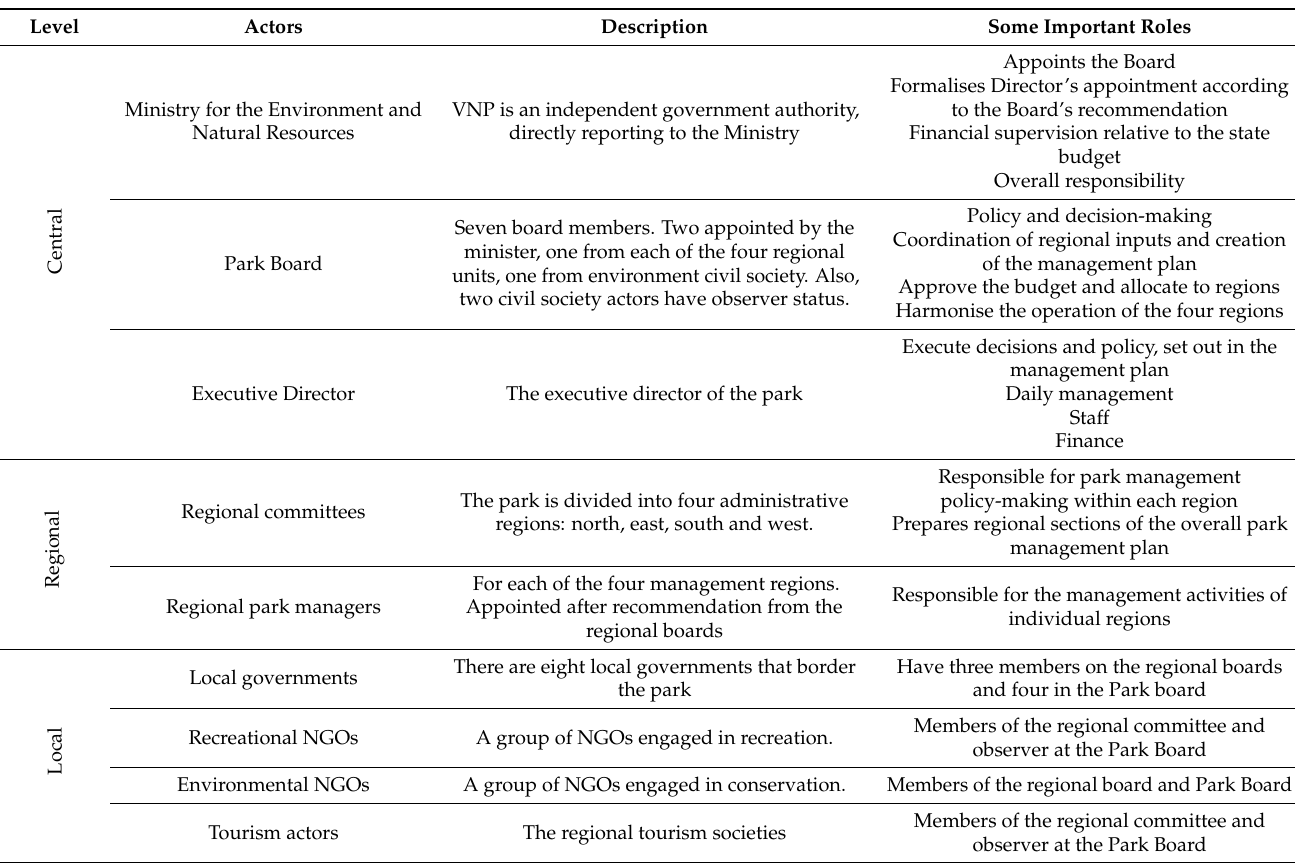
Table 4. Key actors and their roles in governance of Vatnajökull